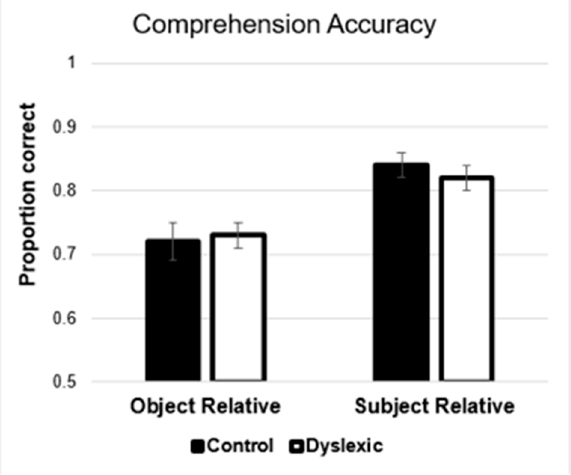
Figure 2. Sentence ‘Type’ by verbal intelligence interaction.